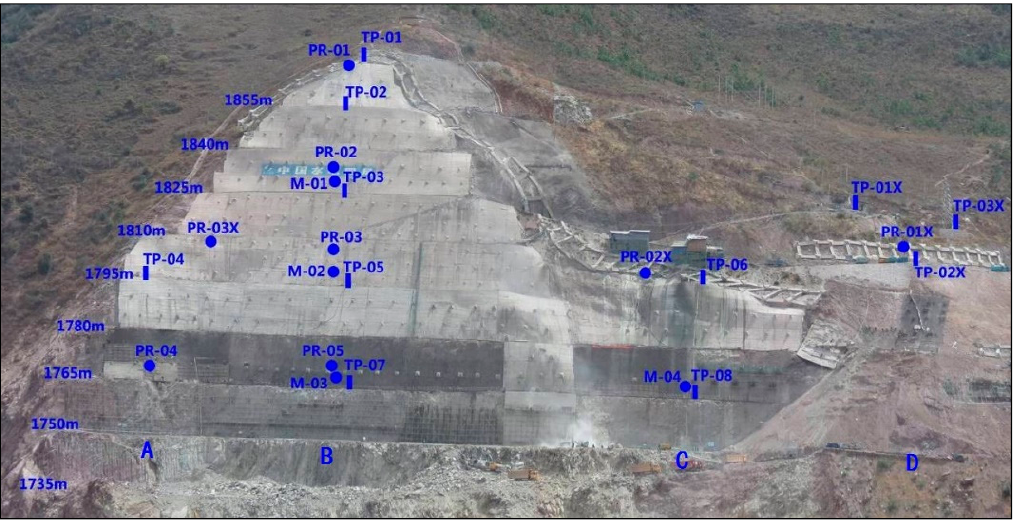
Figure 6. Monitoring allocation in typical slopes of Huangdeng.